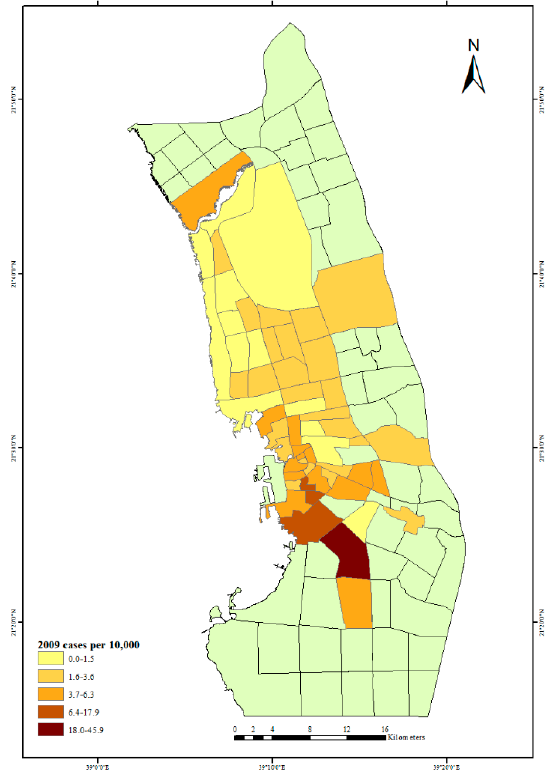
Figure 6. Dengue fever cases per 10,000 people in Jeddah City, 2009.